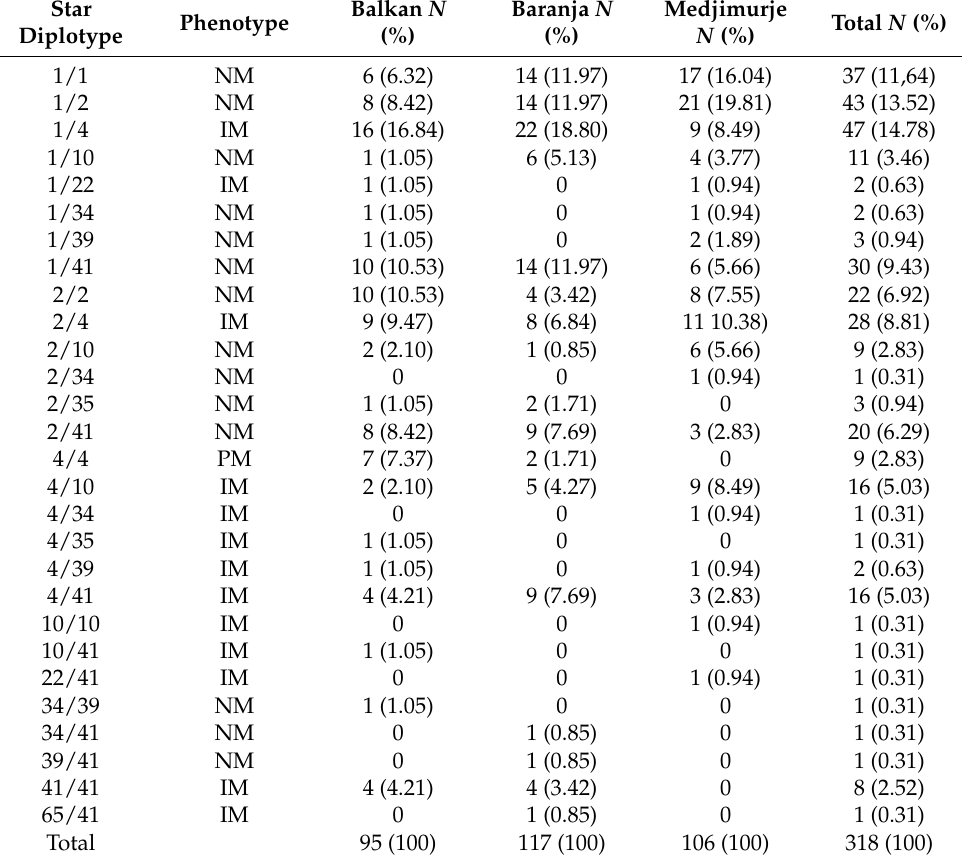
Table 4. Distribution of star diplotypes and approximation of phenotypes in the total Croatian Roma population and in the three subpopulations separately (Balkan, Baranja, Medjimurje).